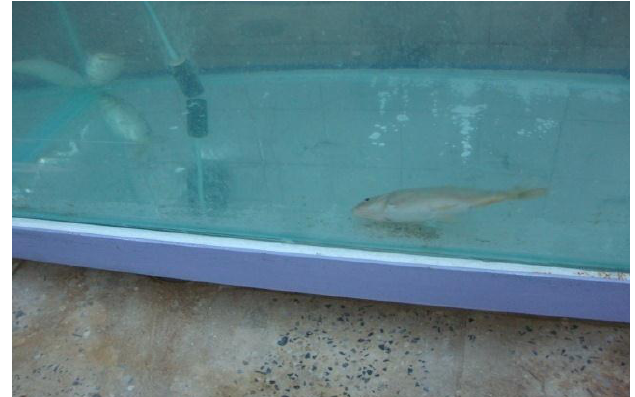
Fig. 2: Show fish sinking to the bottom of the aquarium